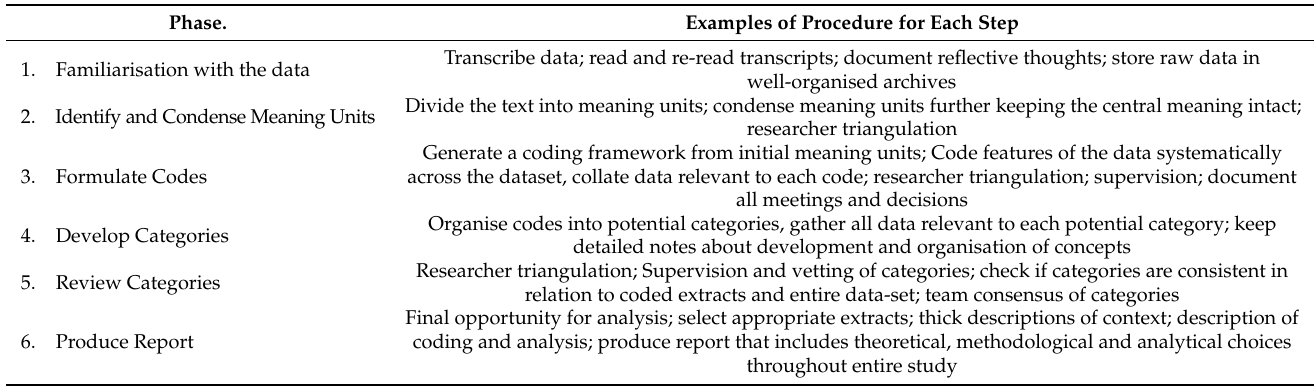
Table 1. Content Analysis Procedure Adapted from Erlingsson and Brysiewicz [40].